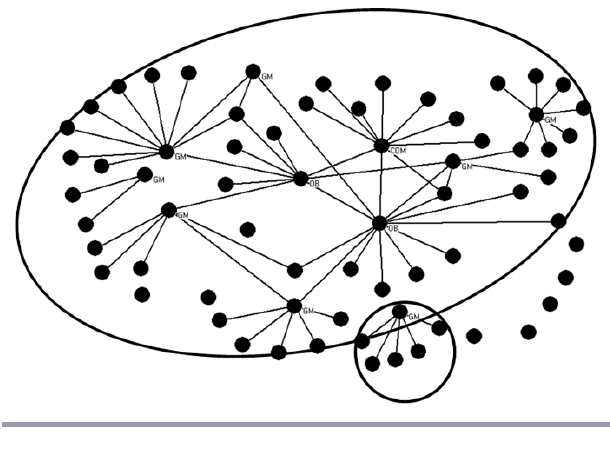
Fig. 10 . Landcare Group B interest clusters - weeds and pest